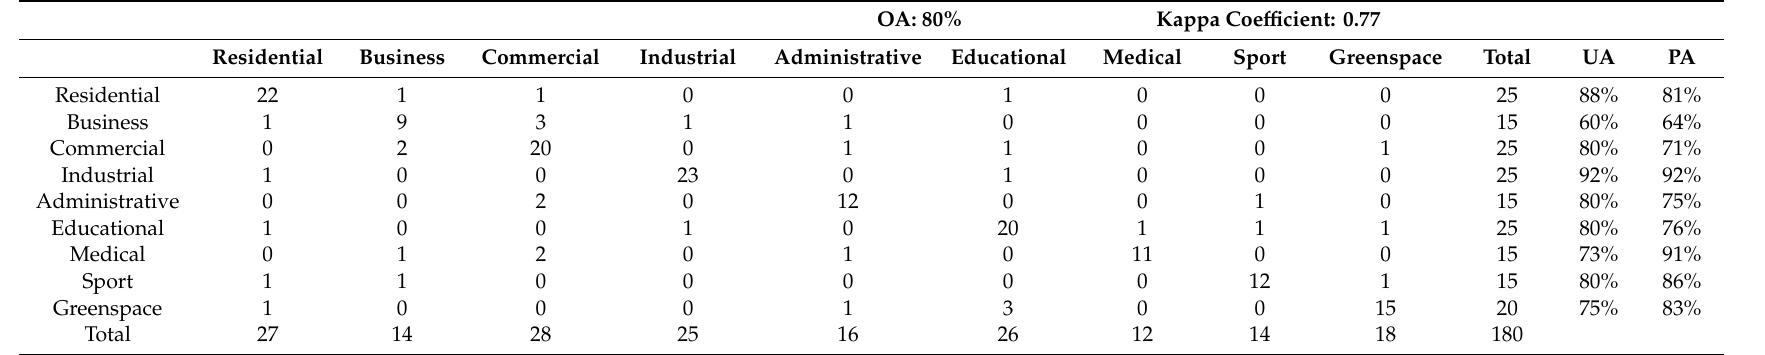
Table 6. Confusion matrix for Level II categories in